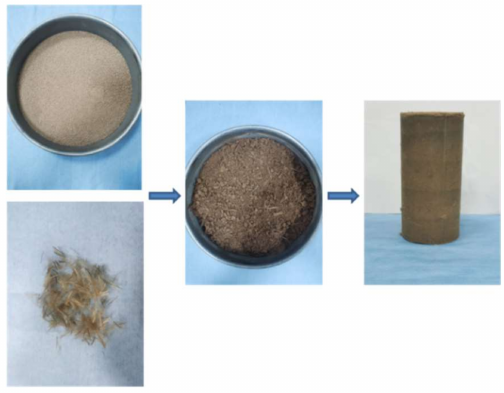
Figure 1. Flow chart of the sample preparation.